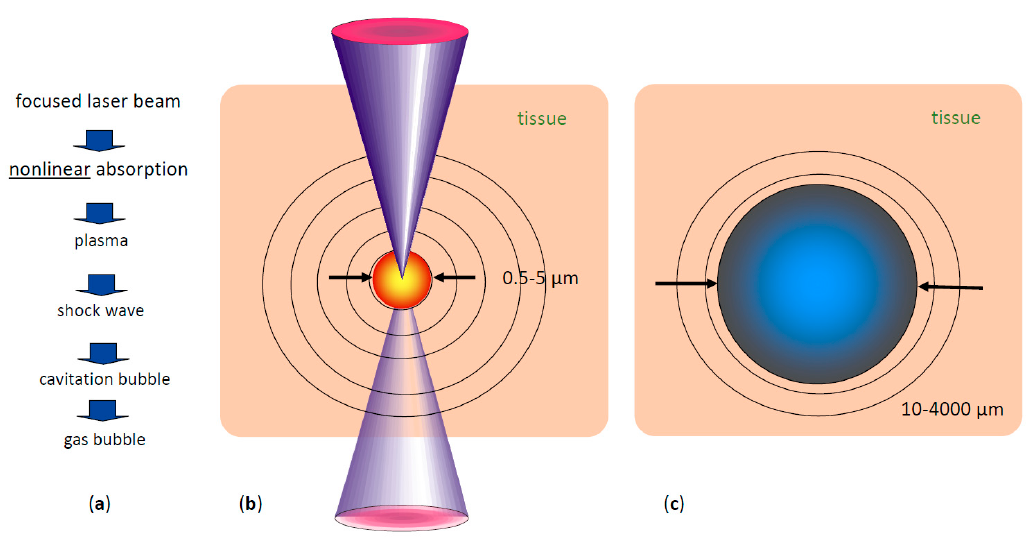
Figure 2. Short pulse laser effects in tissue: ( a ) sequence of effects and induced events, ( b ) plasma size range and pressure wave pattern, ( c ) range of possible cavitation bubble dimensions (pulse energy-dependent) [9].